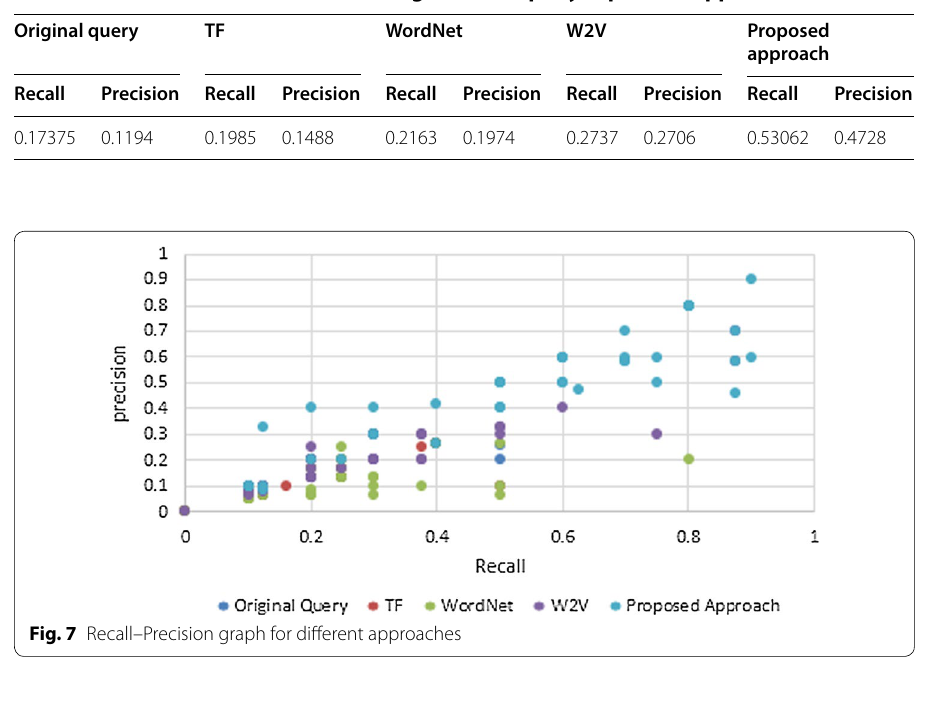
Table 8 Recall and Precision values using different query expansion approaches